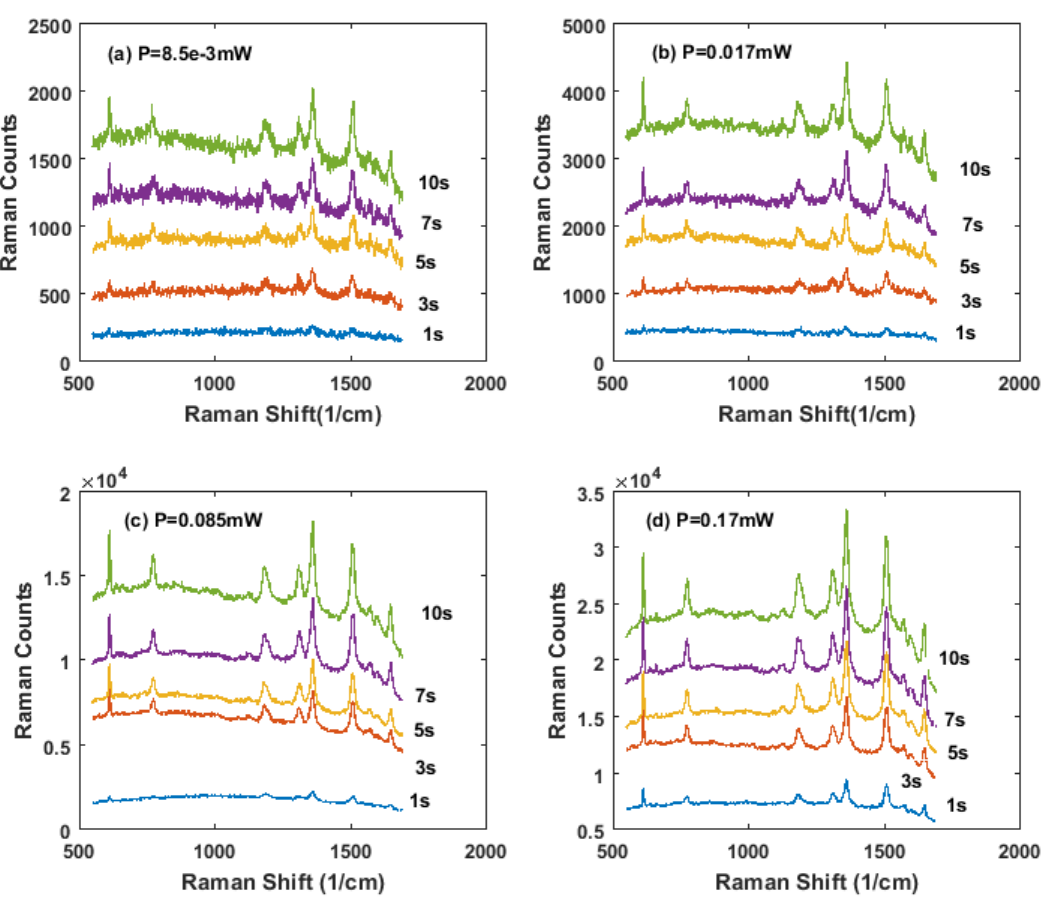
Figure 4. SERS measurement of R6G = 1 × 10 − 6 M with sample S3 at different laser powers and different exposure times. The laser excitation for all ( a – d ) were 633 nm, and objective was 50X. Different exposure times at 1 s, 3 s, 5 s, 7 s, and 10 s were set for each test. ( a ) The laser power was 8.5 × 10 − 3 mW; ( b ) the laser power was 0.017 mW; ( c ) the laser power was 0.085 mW; ( d ) the laser power was 0.17 mW.